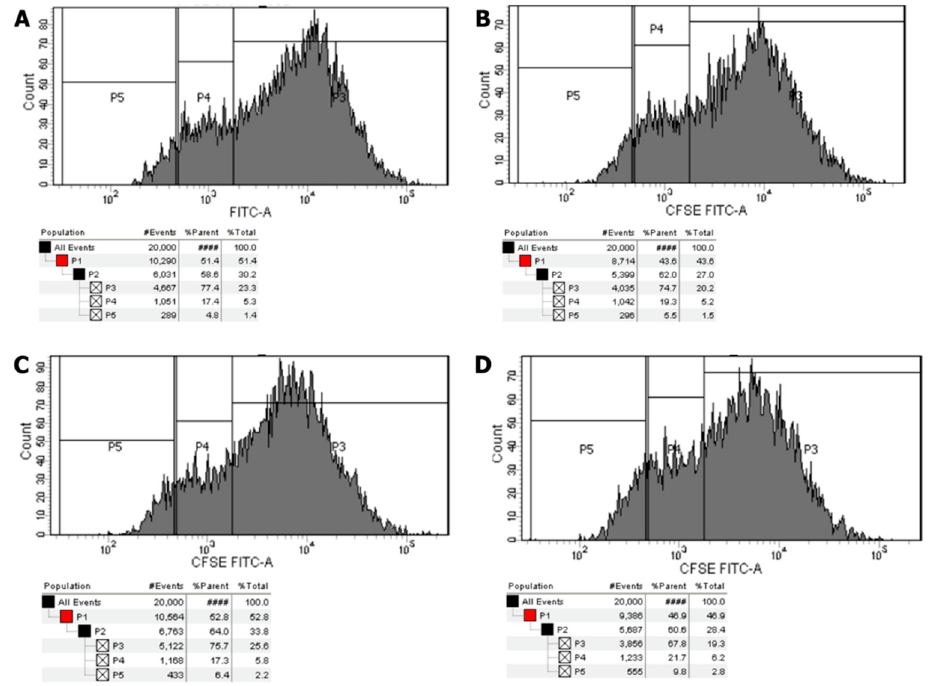
Figure 5. Flow cytometric analysis. Flow cytometric analysis of Sertoli cells stained with carboxyfluorescein diacetate N-succinmidyl ester (CFSE) without stimulation ( A ), and after incubation with hpFSH ( B ), rInsulin ( C ), hpFSH and rInsulin ( D ). Gray peaks represent successive generations.